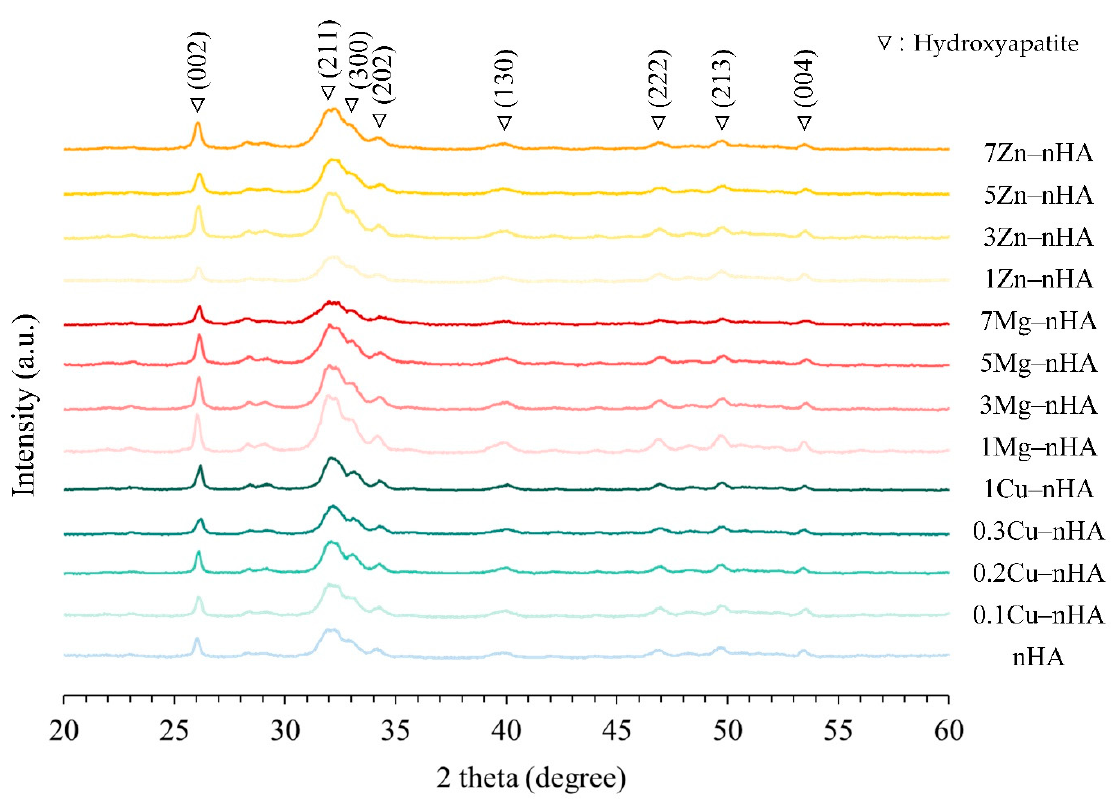
Figure 2. X-ray diffraction patterns of the rod-shaped nanoapatites synthesized with and without Cu 2+ , Mg 2+ , and Zn 2+ at different ion concentrations. Table 1. Calculation of full width at half maximum values from X-ray diffraction patterns of rod- shaped nanoapatites synthesized with different concentrations of Cu 2+ , Mg 2+ , and Zn 2+